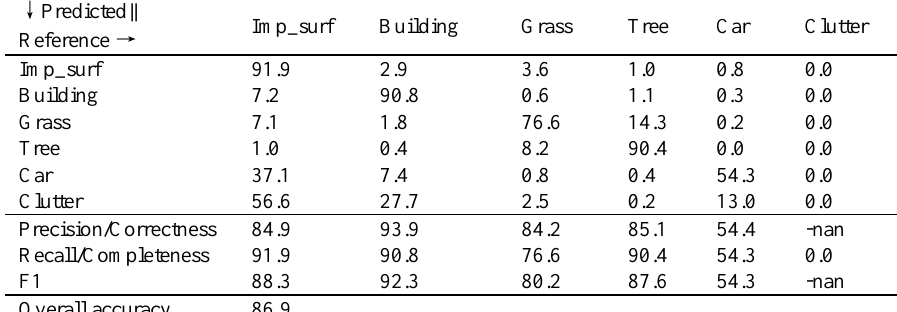
Table 1. Accumulated confusion matrix and some derived measures (precision, recall and F1 score) of ISPRS Semantic Labeling Contest benchmark on the unseen testing set.